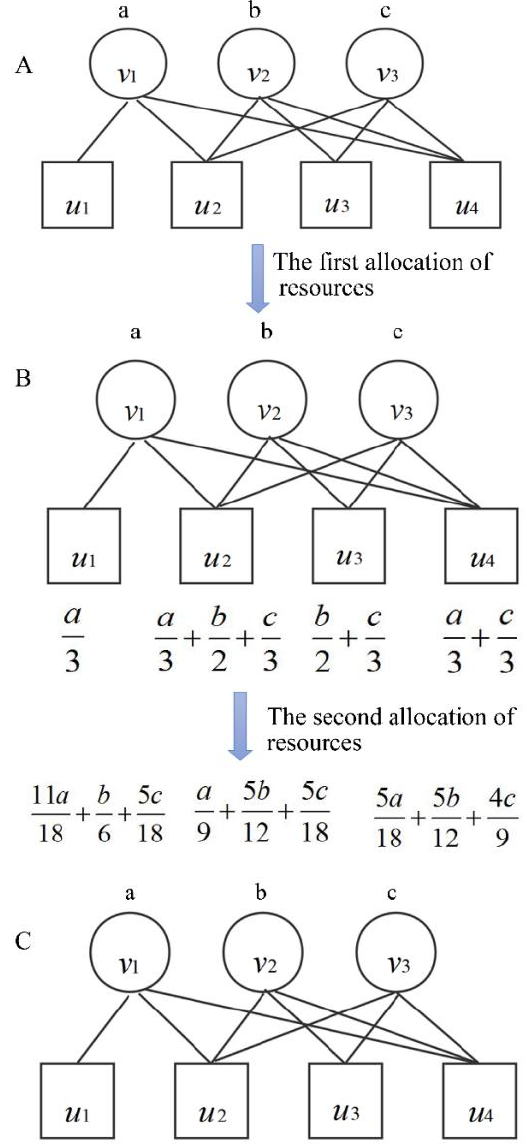
Figure 2. Process of massive diffusion in the bipartite graph. ( A ) shows the initial state of resource allocation. The whole resource allocation process is divided into two stages: in the first stage, resources are from v to u, as shown in ( A , B ). In the second stage, the resources are from u to v, as shown in ( B , C ).